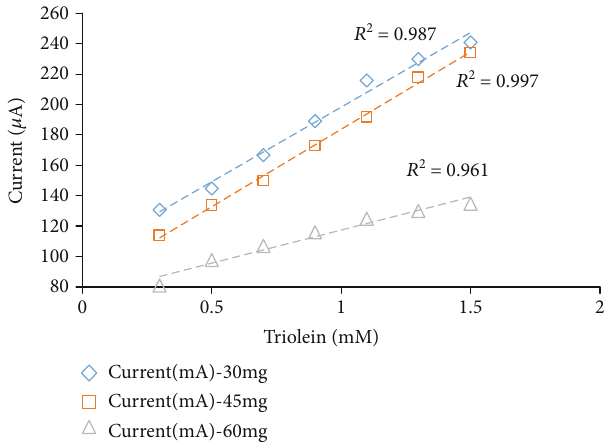
Figure 3: The e ff ect of the amount of gelatin concentration on biosensor response.